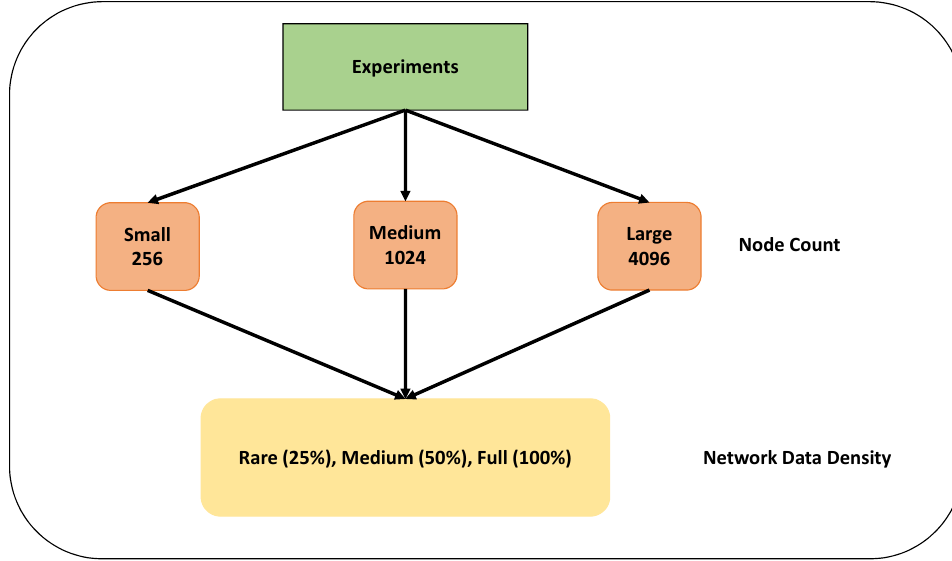
Figure 3. Parameter sweeping